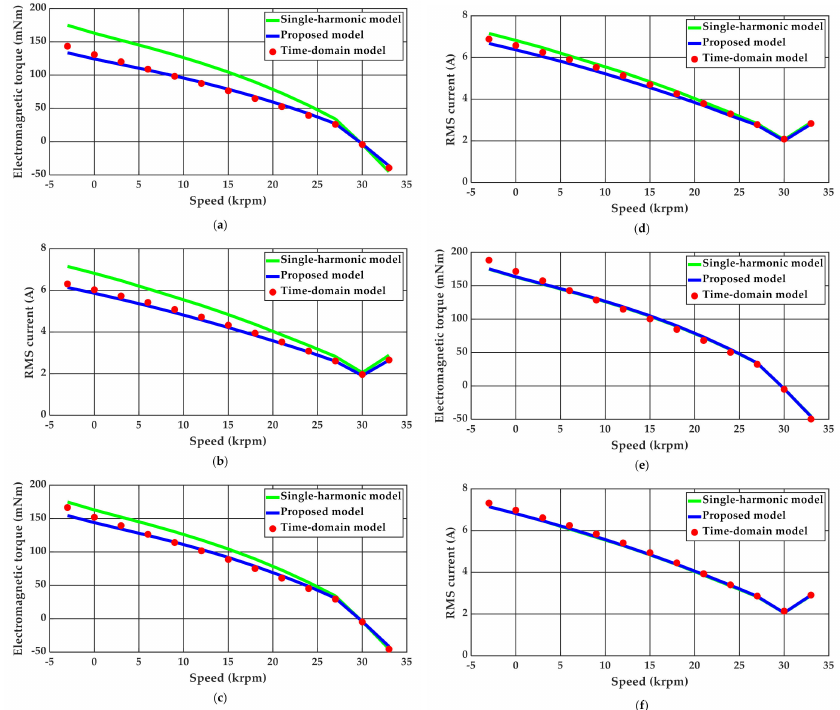
Figure 4. Results of computations: electromagnetic torque ( a ) and RMS stator current ( b ) for square supply waveforms (see Figure 3a); electromagnetic torque ( c ) and RMS stator current ( d ) for six- step supply waveforms (see Figure 3b); electromagnetic torque ( e ) and RMS stator current ( f ) for trapezoidal supply waveforms (see Figure 3c). Results obtained using the single-harmonic model and the proposed model are practically the